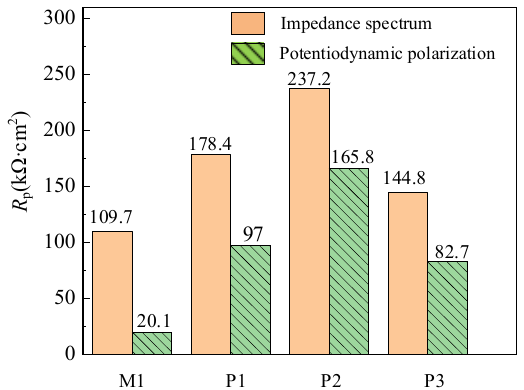
Figure 13. Polarization resistance of milling and electrochemical polishing samples.